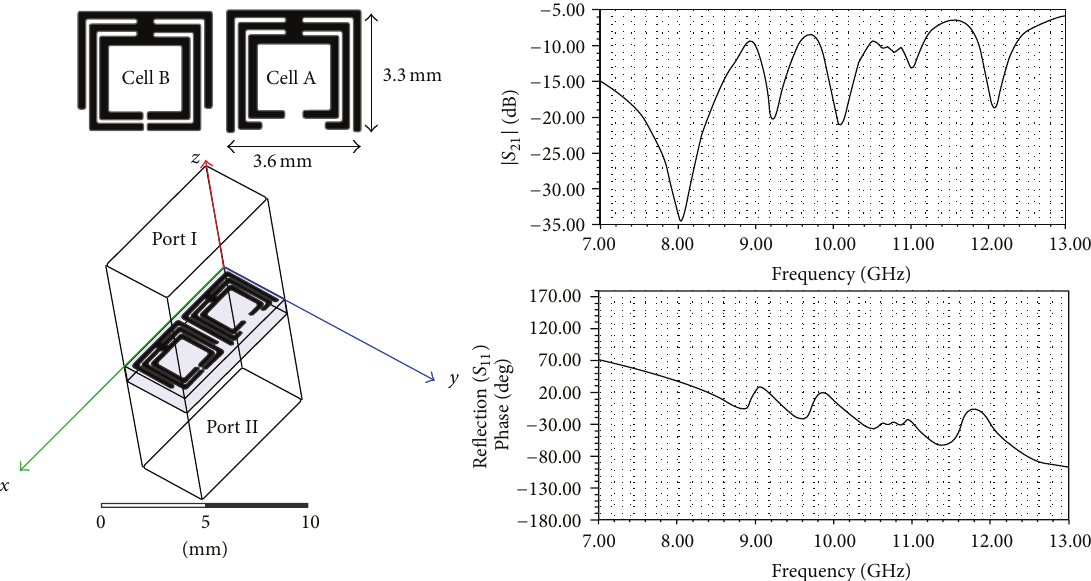
Figure 4: Reflected-wave unit-cell box study setup of the double cells, dimensions, and the related results, S 21 and the phase of S 11 .